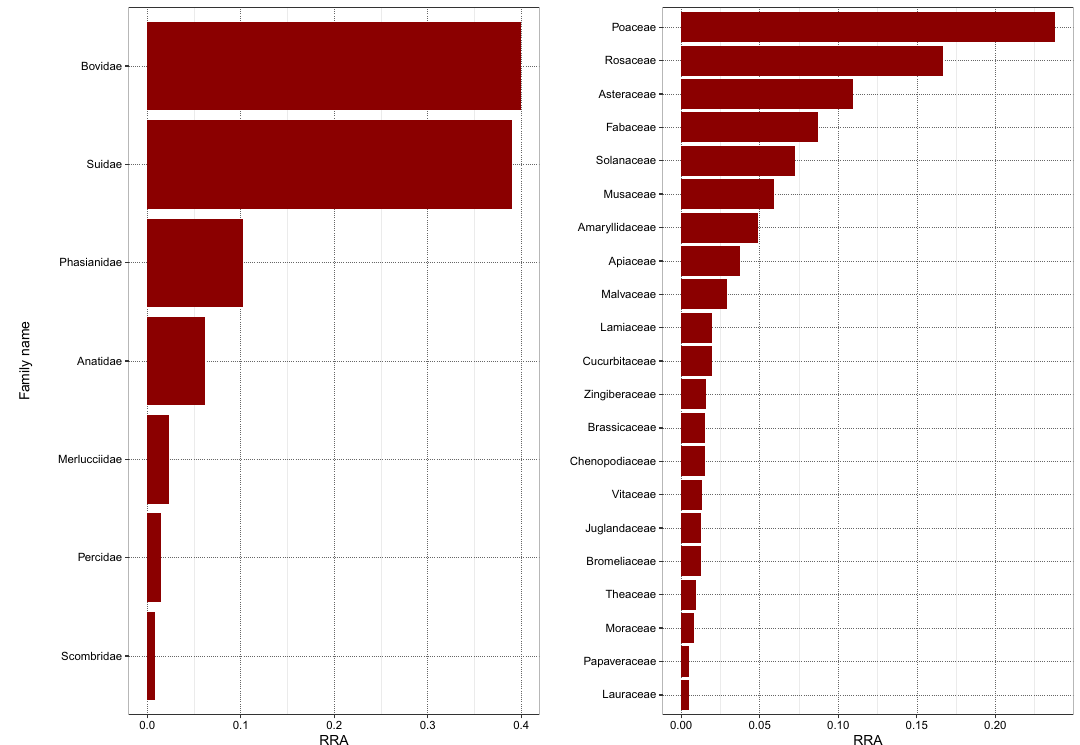
Figure 1. Barplot representing the sum of relative read abundances (RRA) for vertebrate (left panel) and plant (right panel) items across all samples at family level. Human reads were removed before calculating RRA